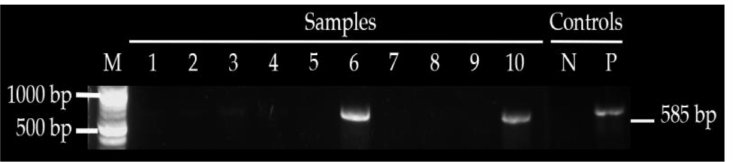
Figure 4. Shows amplified CTX—M in sample 6 and 10, M—1 kb ladder, NC—negative control and PC—positive